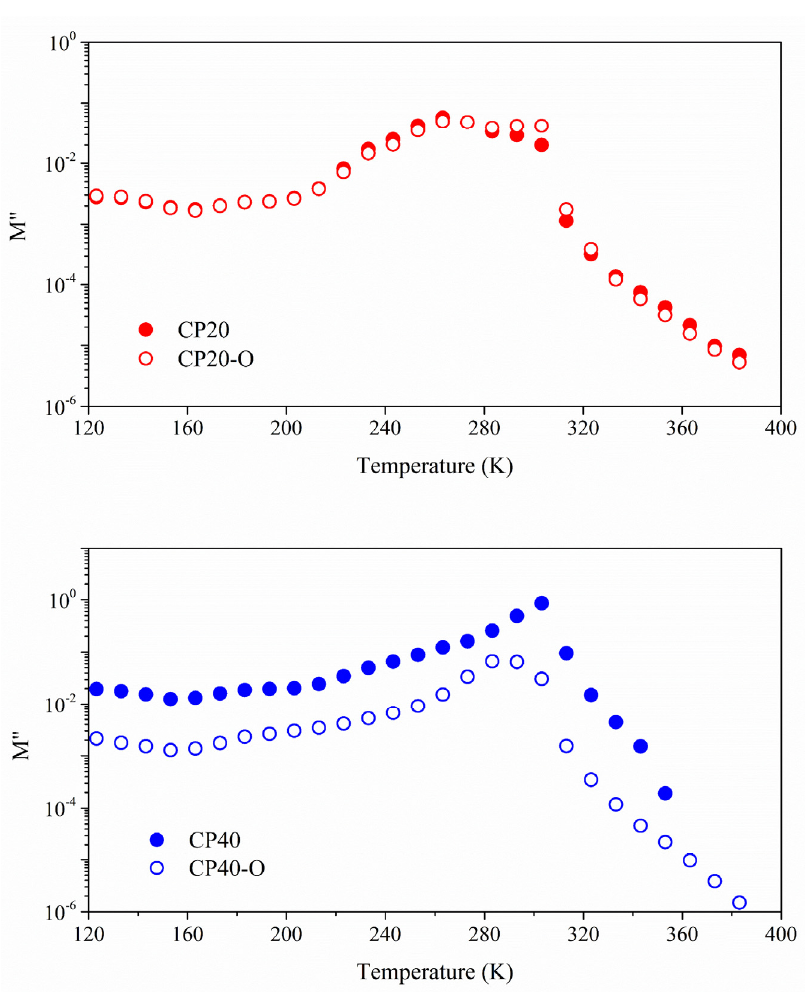
Figure 10. Loss modulus for the modified oriented and unoriented copolymers at 10 − 1 Hz frequency. Table 4. Parameters for the VFTH model and derived parameters for the study of the α Tg relaxation of the modified oriented and unoriented copolymers.